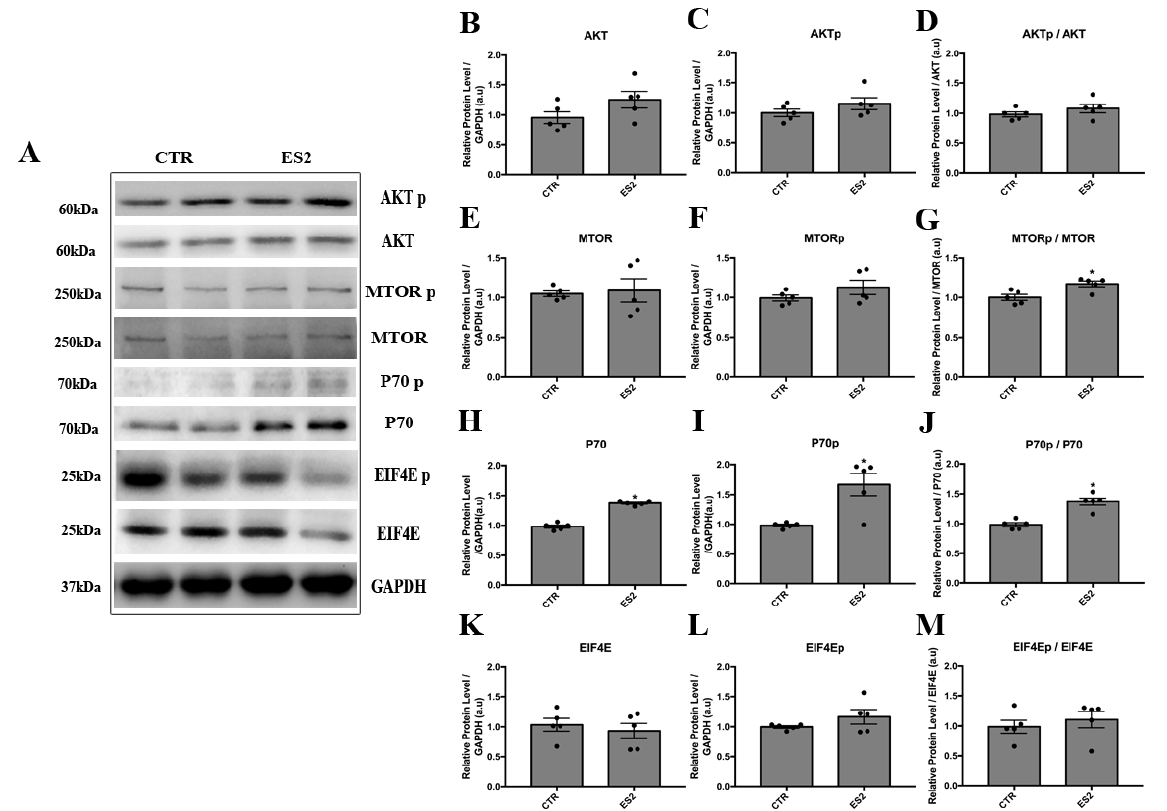
Figure 6. Phosphorylation and total protein implicated in AKT/mTOR signaling following two weeks of electrical stimulation. ( A ) representative band patterns of AKT-mTOR elements after electrical stimulation for two weeks. AKT ( B – D ), mTOR ( E – G ), P70 ( H – J ), and EIF4E ( K – M ) bands were analyzed by densitometry (n = 5 per group). The data are presented mean ± SD. In the statistical analysis, an unpaired t -test and a Mann-Whitney test were employed. * p < 0.05 vs. control group.